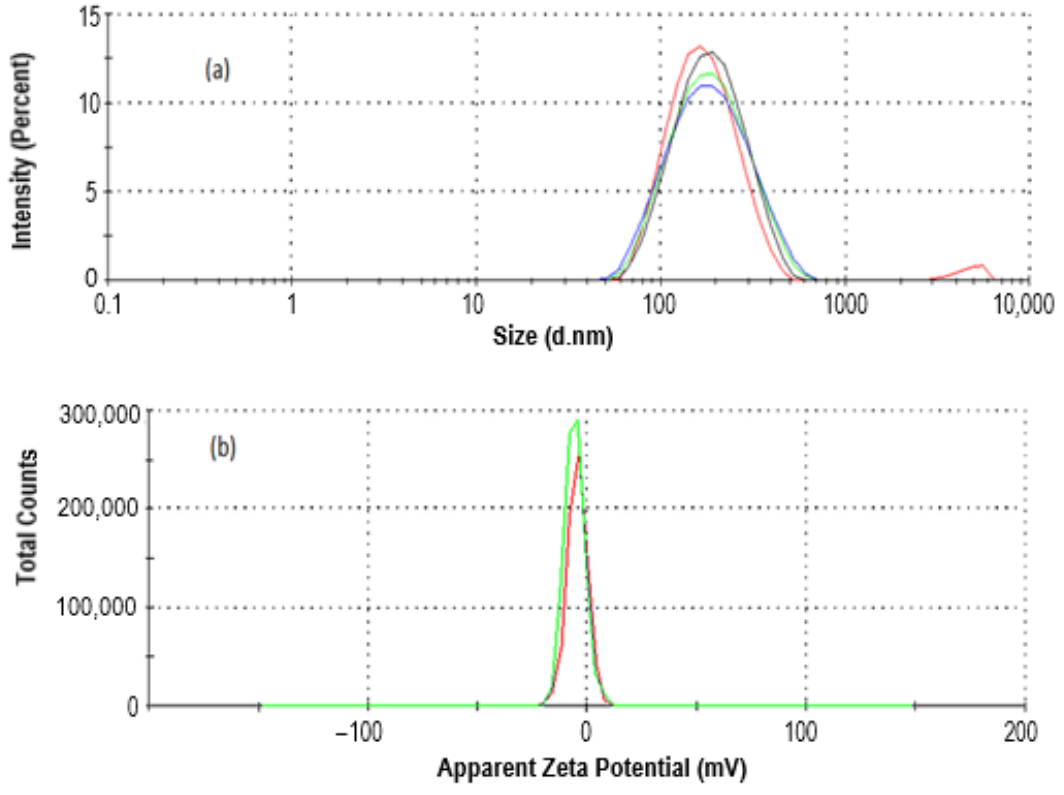
Figure 1. Size and zeta potential analysis of CEO-NE.